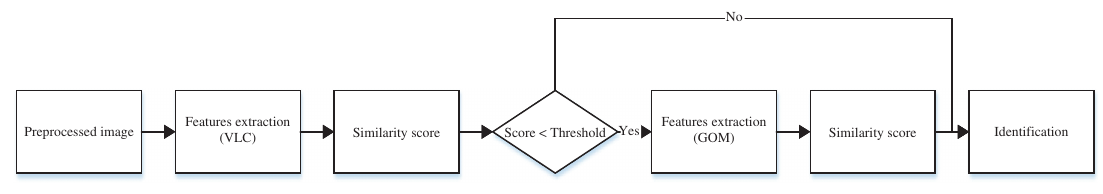
Figure 4: Proposed Face Recognition System.